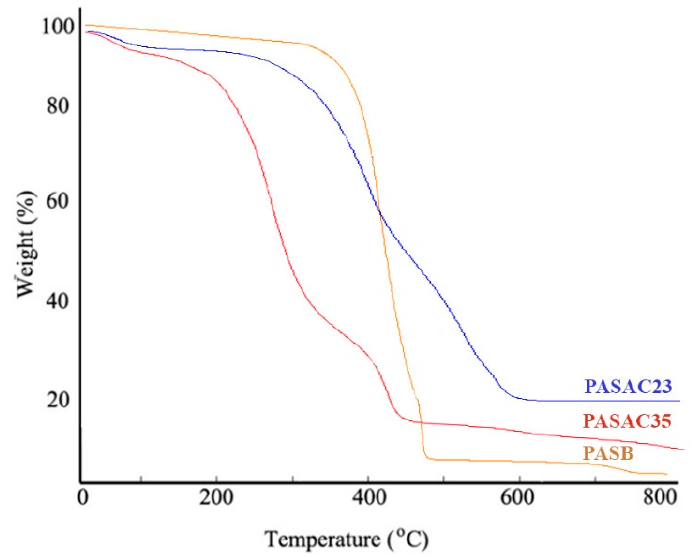
Figure 4. TGA curves of PASB, PASAC23 and PASAC35.